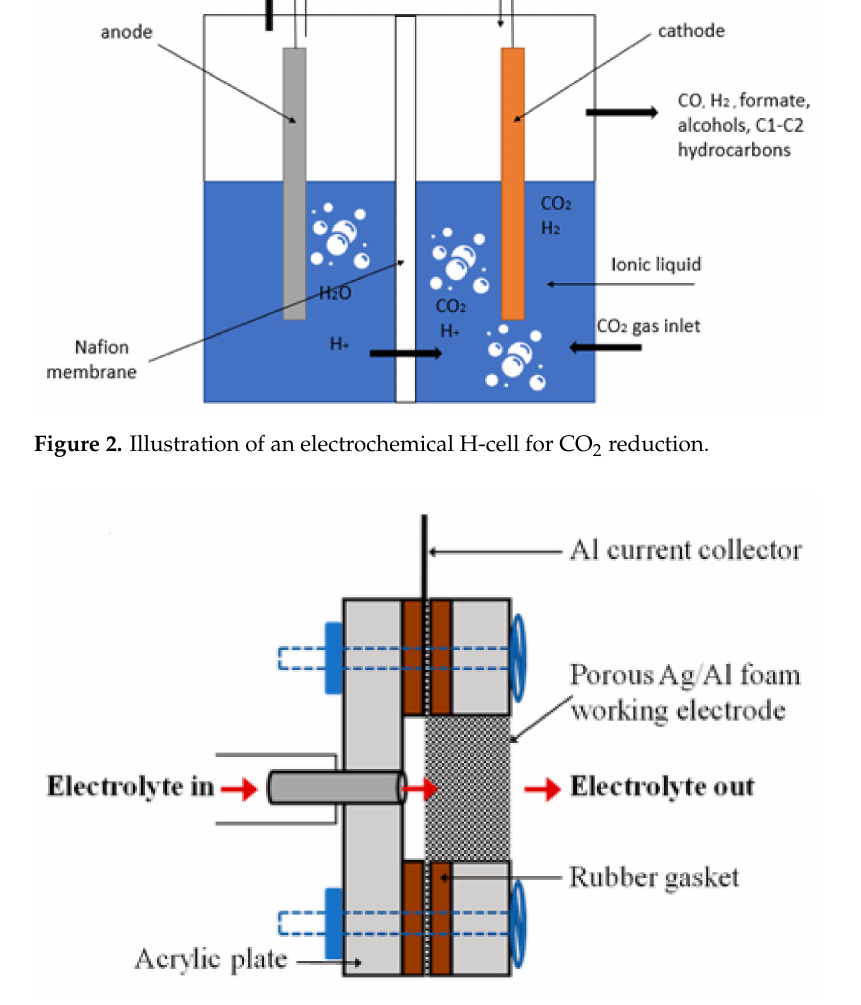
Figure 3. Illustration of the flow cell for CO 2 reduction. Reprinted with permission from [20]. Copyright 2014, American Chemical